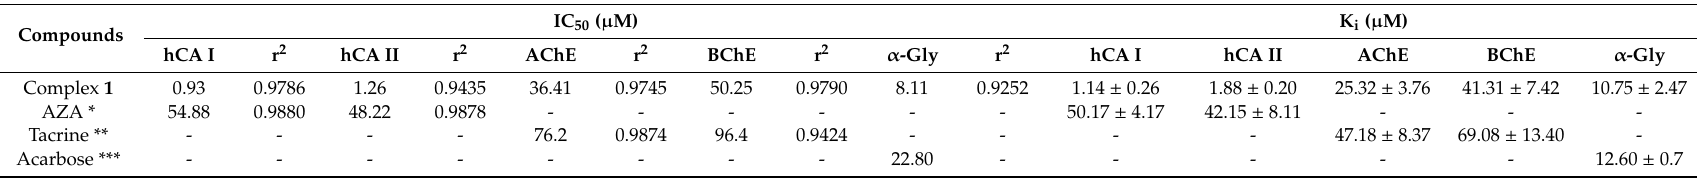
Table 2. The enzyme inhibition results (IC 50 and K i values) of Ag-NHC complex 1 against hCA I, hCA II, α -Glycosidase, AChE, and BChE enzymes.